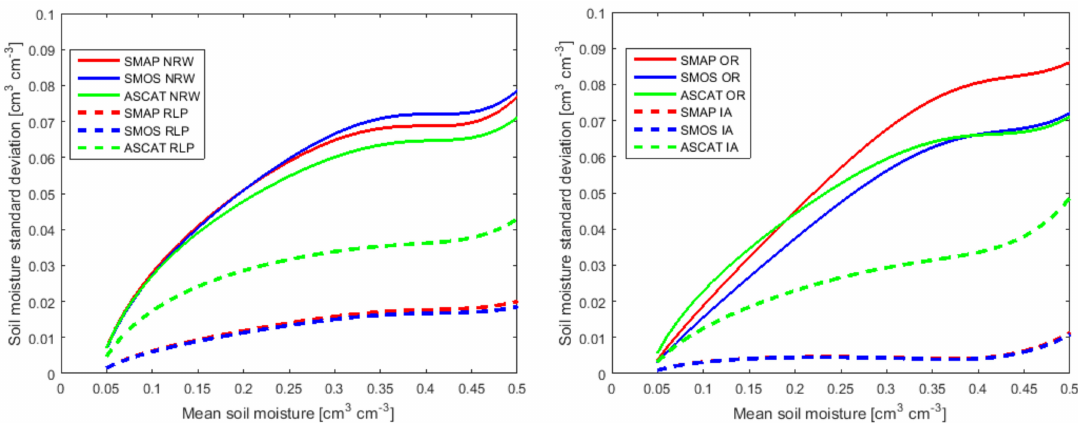
(cid:0) (cid:1) Figure 1. σ θ θ functions for different satellite grid cells at German locations ( left ) and for US locations ( right